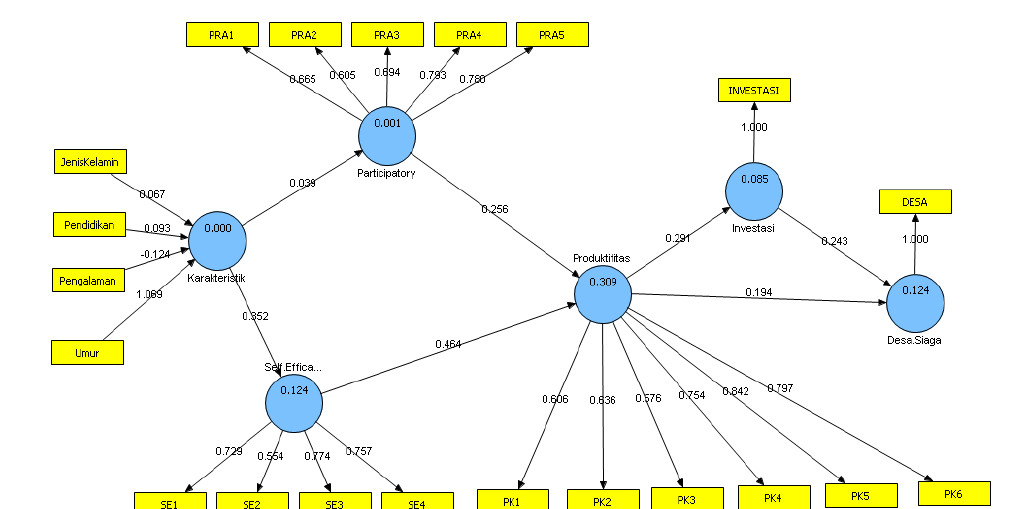
Figure 1. Conceptual Frame work